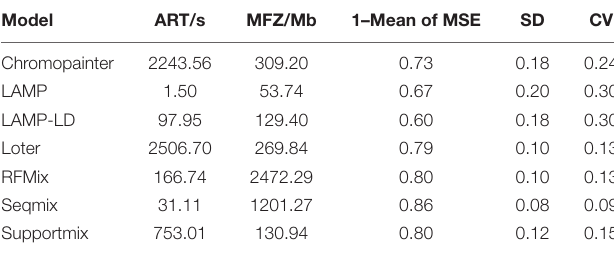
TABLE 3 | Benchmark analysis of most used LAI